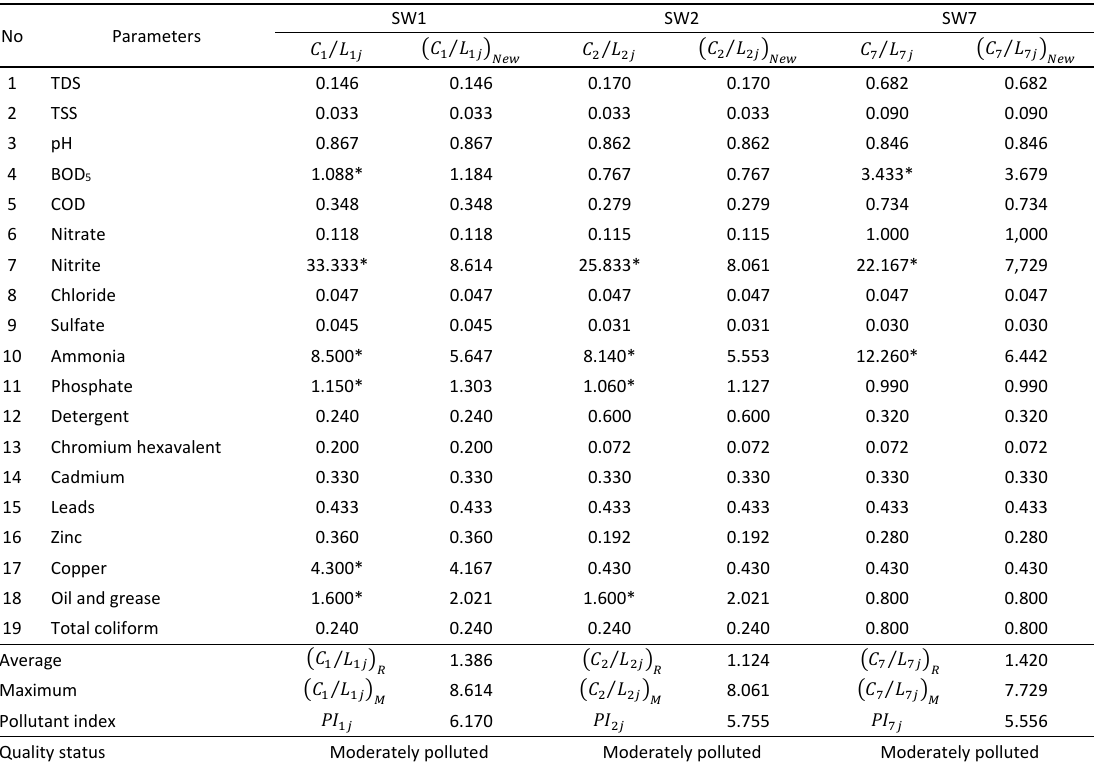
Table 7: Pollution Index values and water quality status at three selected points near the oil and gas production site and office areas in Tuban with 13 additional chemical parameters